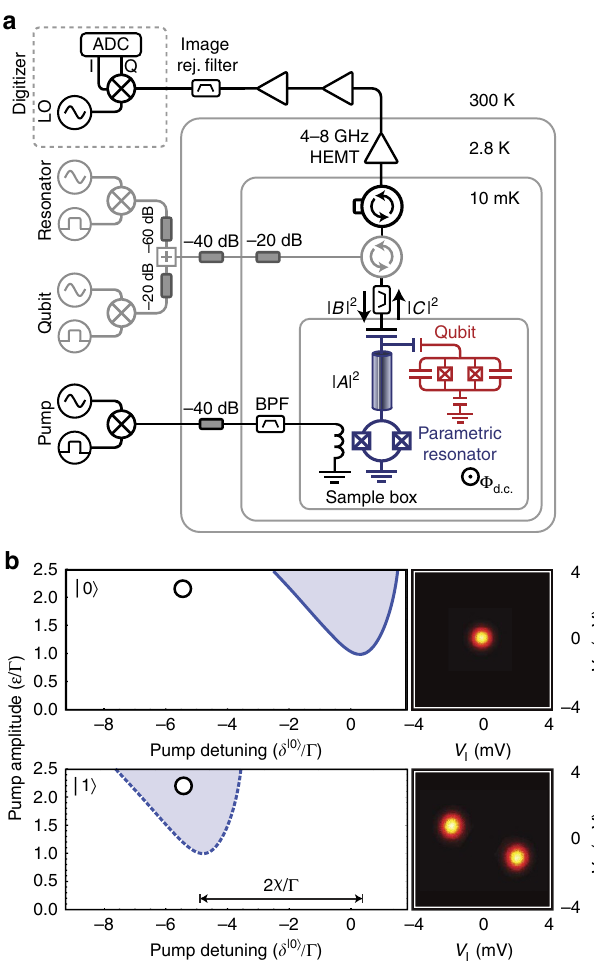
Figure 1 | Experimental set-up and read-out mechanism. ( a ) Schematic of the cryogenic microwave reflectometry set-up. The transmon qubit (red) is capacitively coupled with the coplanar waveguide parametric resonator (blue). The input and output flows of photons are denoted | B | 2 and | C | 2 , respectively, whereas the number of photons in the resonator is denoted | A | 2 . The output signal is acquired using heterodyne detection of the amplified microwave signal. The components drawn in lighter grey are those that are rendered unnecessary by the JPO read-out method, thereby offering a simplified experimental set-up (see text). ( b ) Parametric oscillation regions for the qubit ground state |0 i (solid blue line) and excited state |1 i (dashed blue line), respectively. These blue lines represent the instability boundaries, E ¼ E th , where the number of steady-state solutions to equation (1) changes. The two panels on the right are measured [I,Q]-quadrature voltage histograms of the device output for the pump bias point indicated by the circles, revealing two different oscillator states: outside of the region of parametric oscillations, the resonator is quiet (| A | 2 ¼ 0). Within the region, the resonator has two oscillating states (| A | 2 4 0), with a phase difference of p radians. on the resonator 24,25 . When the JPO is being pumped above the threshold for parametric oscillation, with amplitude E and frequency detuning, d , then a change of qubit state effectively pulls the resonator to a different value of the detuning, outside of the region of parametric oscillations—see Fig. 1b. We denote the qubit-state-dependent detunings by d |0 i ¼ d (cid:2) w and d |1 i ¼ d þ w . The resulting mapping of the qubit state onto the average number of photons in the resonator provides us with a qubit-state read-out mechanism, which we exploit in this work. NATURE COMMUNICATIONS|7:11417|DOI: